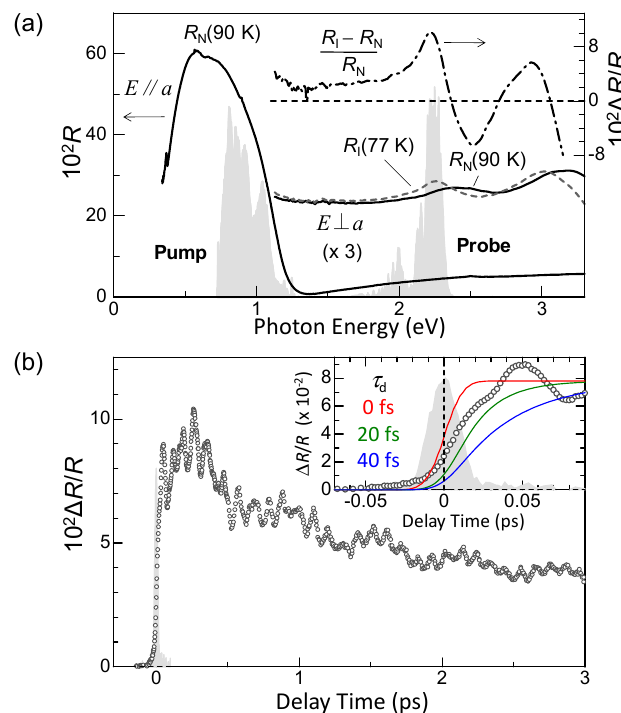
Figure 13. Results of optical-pump optical-reflectivity-probe spectroscopy with the time resolution of ~20 fs in the N phase of TTF-CA [30]. ( a ) Polarized reflectivity spectra at 90 K (solid lines) and at 77 K (the broken line). A differential reflectivity spectrum, [ R I (77 K) − R N (90K)]/ R N (90K), is shown by the dashed-dotted line. Shaded areas show spectra of pump and probe pulses; ( b ) Time evolution of reflectivity changes Δ R / R . The gray shaded area in the inset shows a cross-correlation profile of pump and probe pulses. Solid lines in the inset are simulated time characteristics with different time constant (rise time) τ d of Δ R / R signals.